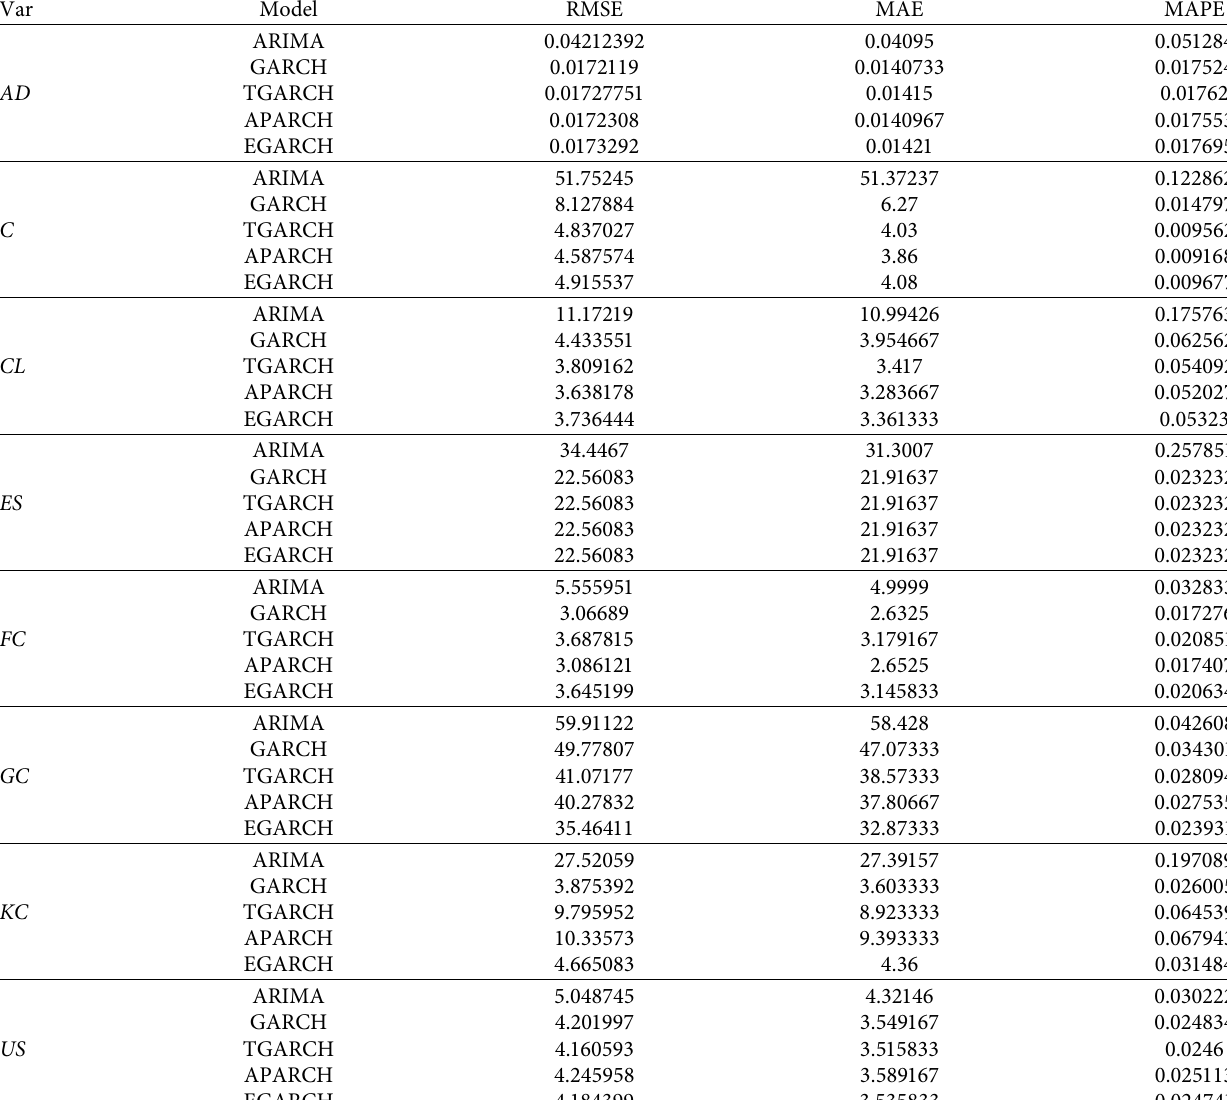
Table 10: Comparison of forecast errors of ARIMA and GARCH